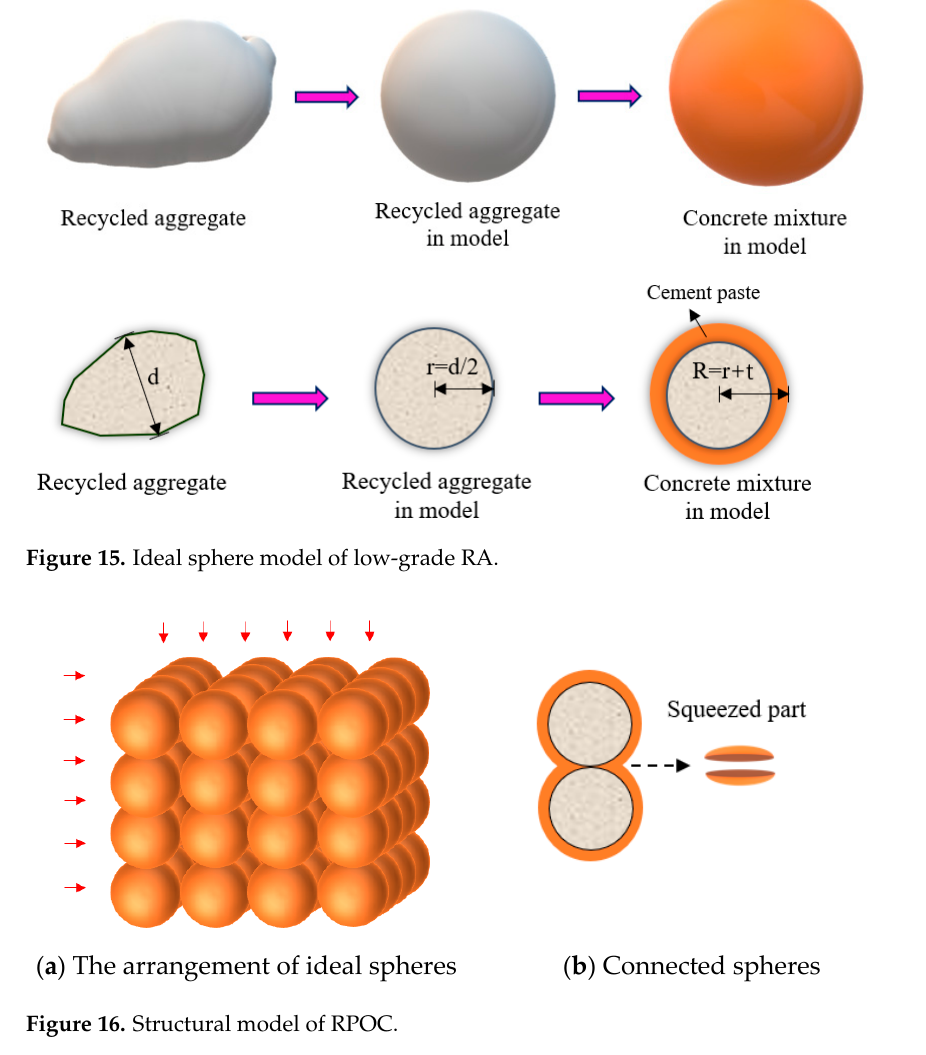
( b ) Connected spheres Figure 16. Structural model of RPOC. Since the compressive damage of POC with low-grade RA mostly occurs at the bond- ing area between aggregates, it is assumed that the fracture surface is the weakest part of the bonding area, as shown in Figure 17. It can be seen that the fracture area is equal to the bonding area between aggregates, which is defined as the effective fracture area. Therefore, the relationship between compressive strength and aggregate bonding area is established. In the numerical calculation, the effective fracture area of a single aggregate is equal to the bottom area of the squeezed part, which can be calculated by the spherical crown formula, as shown in Equations (6) and (7). A = π ( (cid:1872) (cid:2870) +2 tr )